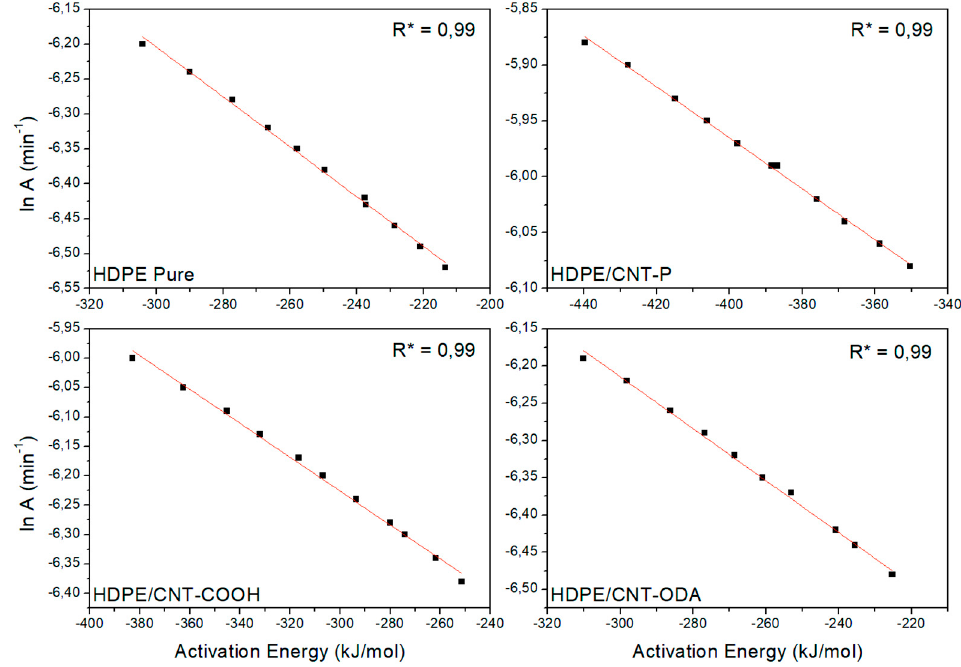
Figure 5. The compensation effect between E a and ln A for pure HDPE and HDPE/CNT